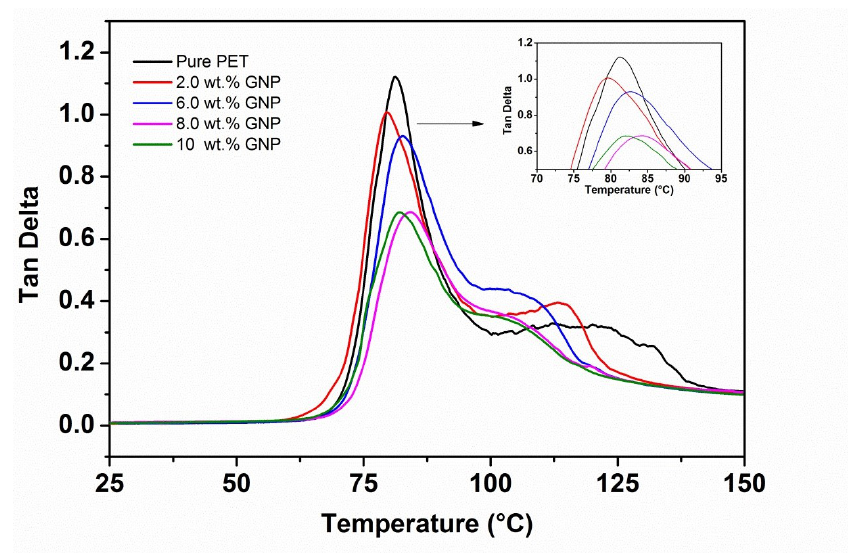
Figure 6. DMTA tan δ versus temperature data for the PET-GNP